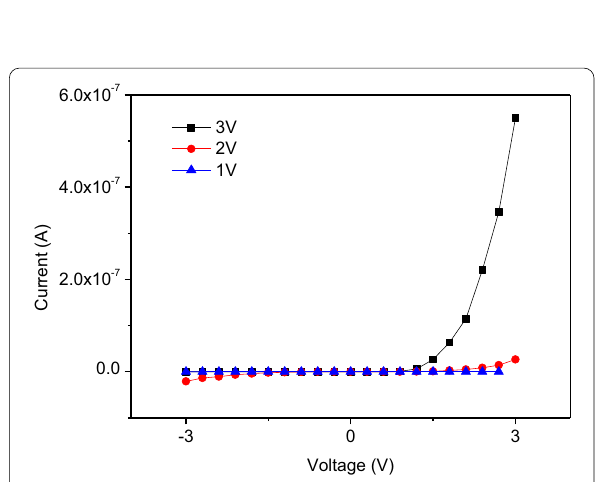
Fig. 4 SEM image of the individual ZnO NW device that was fabricated using a voltage of 3 V in the alignment process and exhibited a rectifying IV